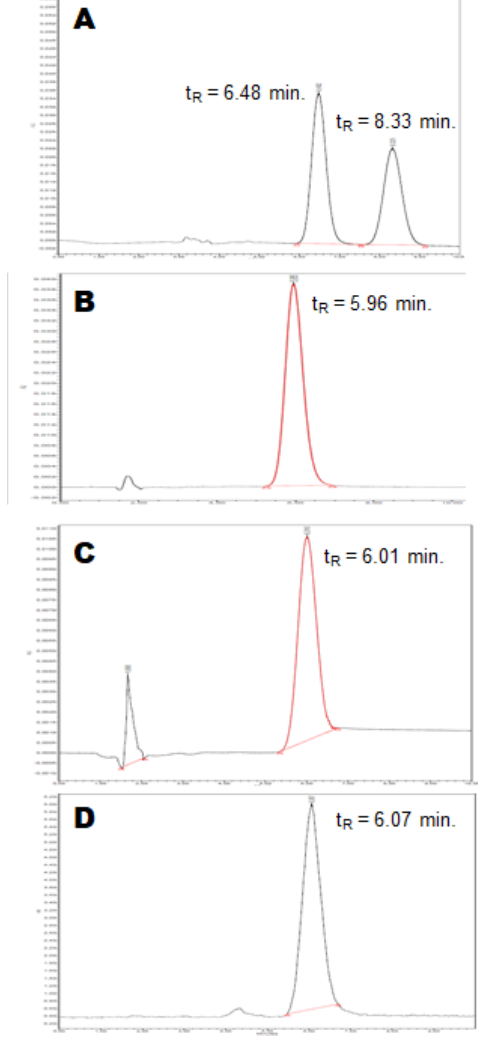
Figure 4. Quality control of [ 18 F] (R)- crizotinib by analytical normal-phase chiral HPLC using a Chiralpak-AD 250 × 4.6 mm 5 µm column (Chiral Technologies, Illkirch-Graffenstaden, France) and a mixture of heptane/ i PrOH/MeOH/ N,N -diisopropylamine (40/30/30/0.5 v/v/v/v , 1 mL/min) as eluent. UV detection was performed at 333 nm. ( A ) UV chromatogram of the racemic reference; ( B ) UV chromatogram of the (R) -crizotinib; ( C ) UV chromatogram of the radiotracer [ 18 F] (R)- crizotinib; ( D ) Gamma chromatogram of the radiotracer [ 18 F] (R)- crizotinib.